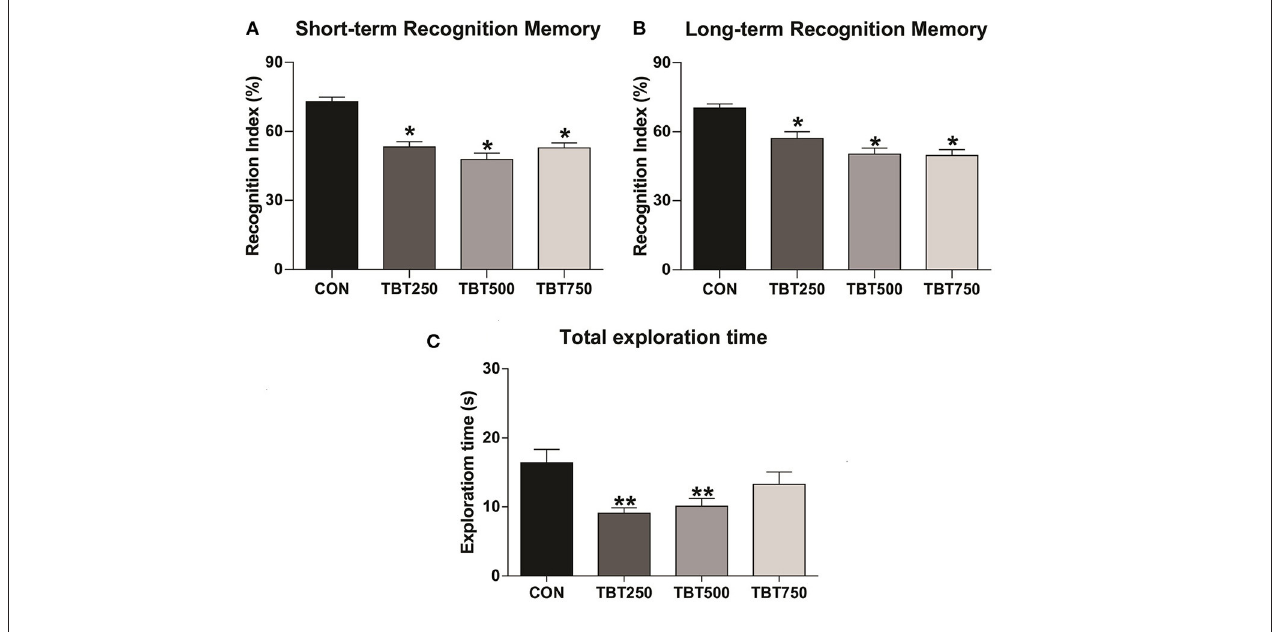
FIGURE 1 | TBT exposure leads to abnormal recognition memory in female mice. Short- (A) and long-term (B) recognition memory performance (STM and LTM, respectively). (C) TBT exposure results in abnormal total exploration time in female mice. A reduction in total exploration time was observed in TBT-treated mice. * p < 0.05 vs. CON; ** p < 0.01 vs. CON (one-way ANOVA, followed by Bonferroni’s test).